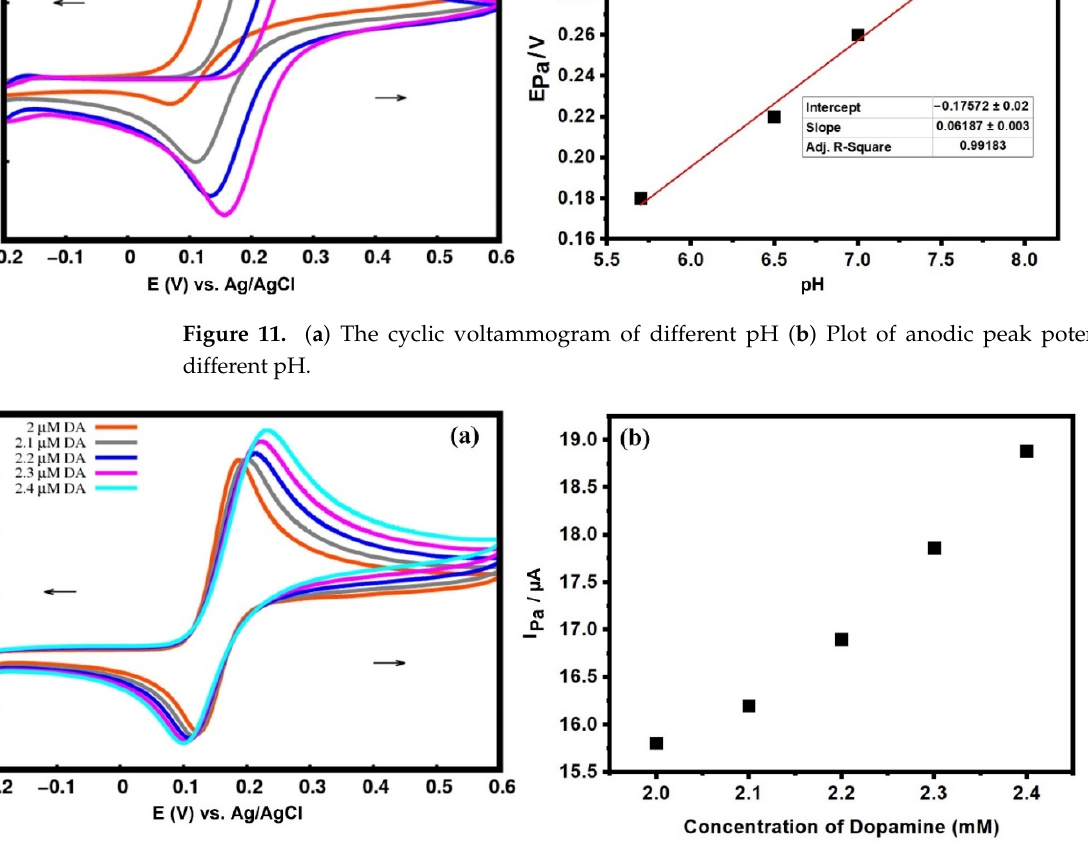
Figure 11. ( a ) The cyclic voltammogram of different pH ( b ) Plot of anodic peak potential vs. different pH.